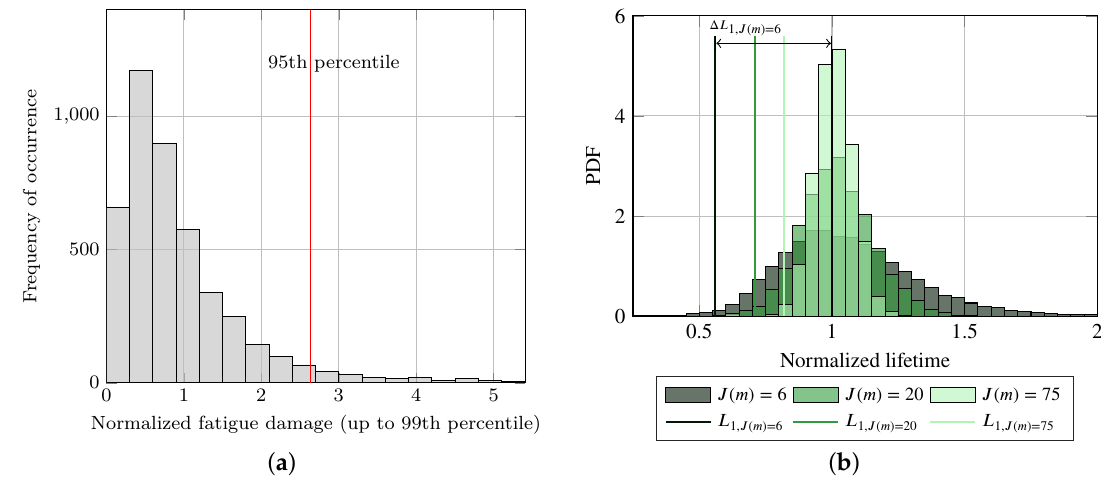
Figure 4. Illustration of the scattering and uncertainty of fatigue damages based on measured strain data for turbine H05. ( a ) Frequency of occurrence of normalized fatigue damages for a wind speed of 16.5ms − 1 < v s < 18.5ms − 1 . The 95th percentile is marked. ( b ) Lifetime PDF for three different numbers of samples ( J ( m ) ) in each bin (EMCS). The 1st percentiles are